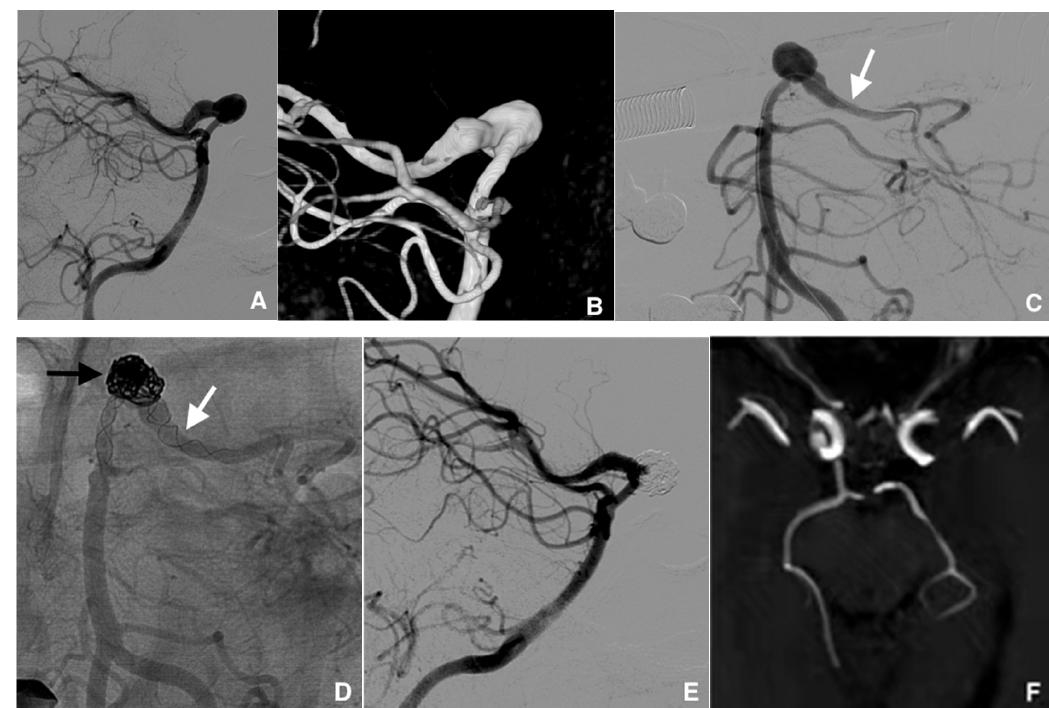
Figure 2. Example of management of a dissecting intracranial aneurysm (IA) (length, 20 mm; wide, 7 mm) in a 52-year-old woman treated with stent-jack technique. ( A ) Pre-treatment digital subtraction angiography (DSA) of the fusiform IA of the left posterior communicating artery (lateral view). ( B ) Image reconstruction of the IA with volume rendering technique. ( C ) Cathetherism of the aneurysm-carrying vessel (white arrow) in a posterior–anterior DSA projection. ( D ) Nonsubtracted post-treatment control DSA image, posterior-anterior projection, showing the widest part of the IA filled with coils (black arrow) and two Leo stents implanted using the telescopic technique (white arrow). ( E ) DSA image at the end of the procedure, lateral projection: the IA is partially excluded from the intracranial circulation. ( F ) Magnetic resonance imaging with 3D time-of-flight view, at 36 months posttreatment control: the IA is completely excluded and the formerly aneurysm-carrying vessel displays regular endoluminal signal.